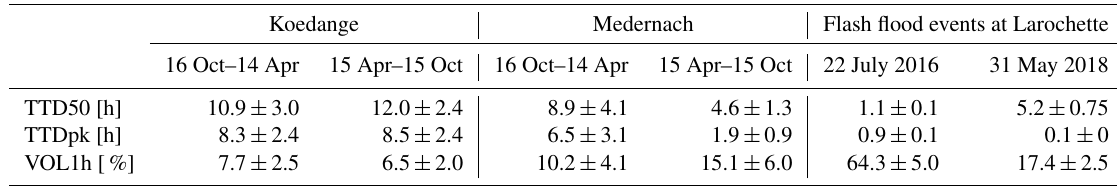
Figure 9. Properties of the simulated transfer time distributions: the median transfer time (TTD50 [h], a ), the peak flow lag time (TTDpk [h], b ), and the runoff response concentration in 1h (VOL1h [%], c ). The events are ordered by calendar day. The orange and green envelopes correspond to the average calendar values, based on the three closest estimates and taking into account the uncertainties of the metric (TTD50, TTDpk, or VOL1h) assessments. The purple arrow on the third panel points to VOL1H of the flash flood of July 2016 which exceeds the graph scale (VOL1H = 64.3%). Table 5. Seasonal average of the TTD